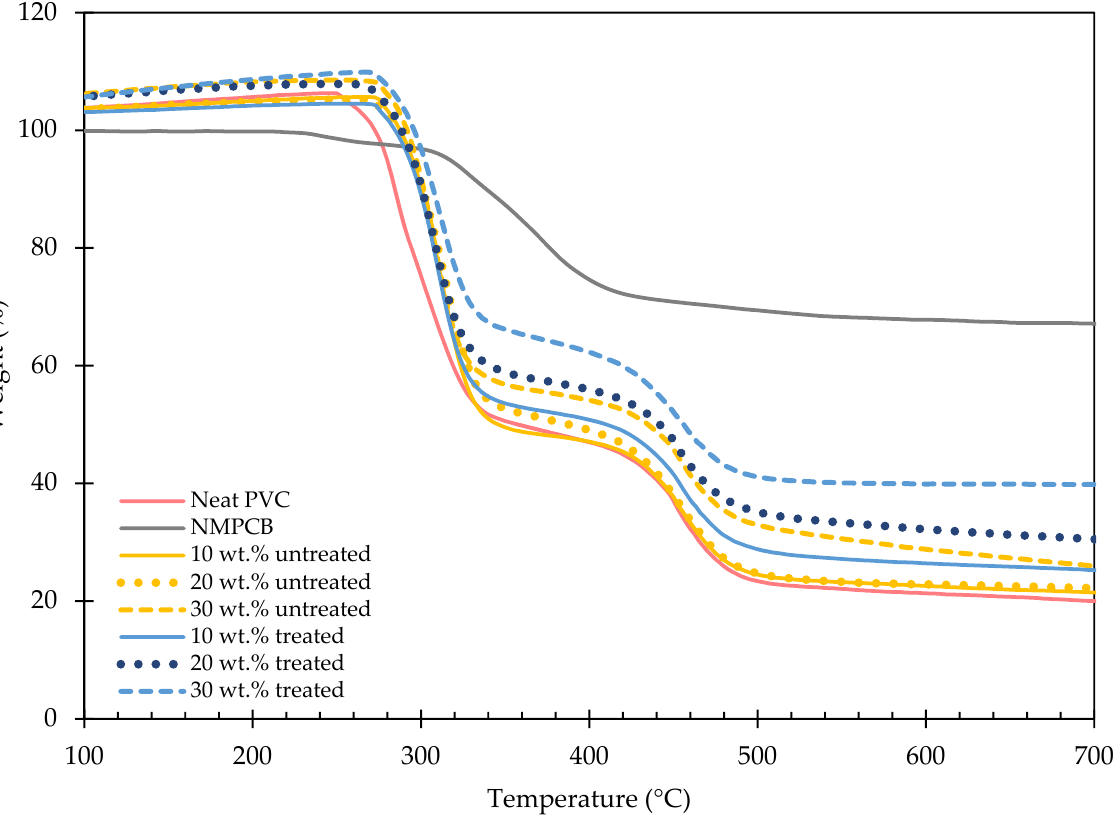
Figure 8. Weight loss of the untreated and treated NMPCB/PVC composites.